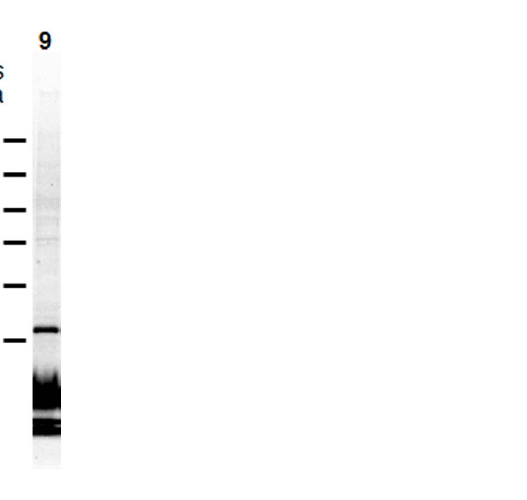
Fig. 3. Production of different membrane proteins using the cell-free system. After synthesis of the membrane proteins in the cell-free system in the presence of FluoroTect Green Lys tRNA, the membrane fraction was precipitated and separated by SDS/PAGE. (A) 10% polyacrylamide gel; lane 1, AtKC1 (plant, K + channel, 6 transmembrane segments (TMS)); lane 2, KAT1 (plant, K + channel, 6 TMS); lane 3, KAT2 (plant, K + channel, 6 TMS); lane 4, GORK (plant, K + channel, 6 TMS); lane 5, AKT1 (plant, K + channel, 6 TMS); lane 6, NhaA (bacteria, Na + /H + antiporter, 10 TMS); Lane 7, AspT (bacteria, aspartate: alanine antiporter, 10 TMS); lane 8, MsbA (bacteria, ABC transporter, 12 TMS). (B) 15% polyacrylamide gel; lane 9, Sec61 b (human, 1 TMS).